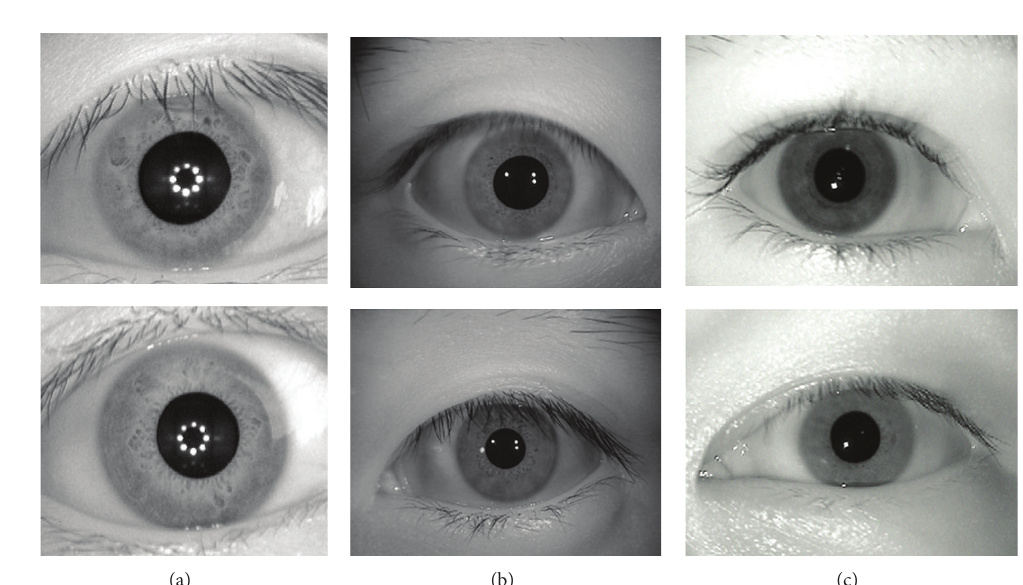
Figure 13: Sample images from CASIA-V3 Interval, CASIA-V3 Lamp, and MMU-V1 iris databases. (a) CASIA-V3-Interval, (b) CASIA-V3 Lamp, and (c)